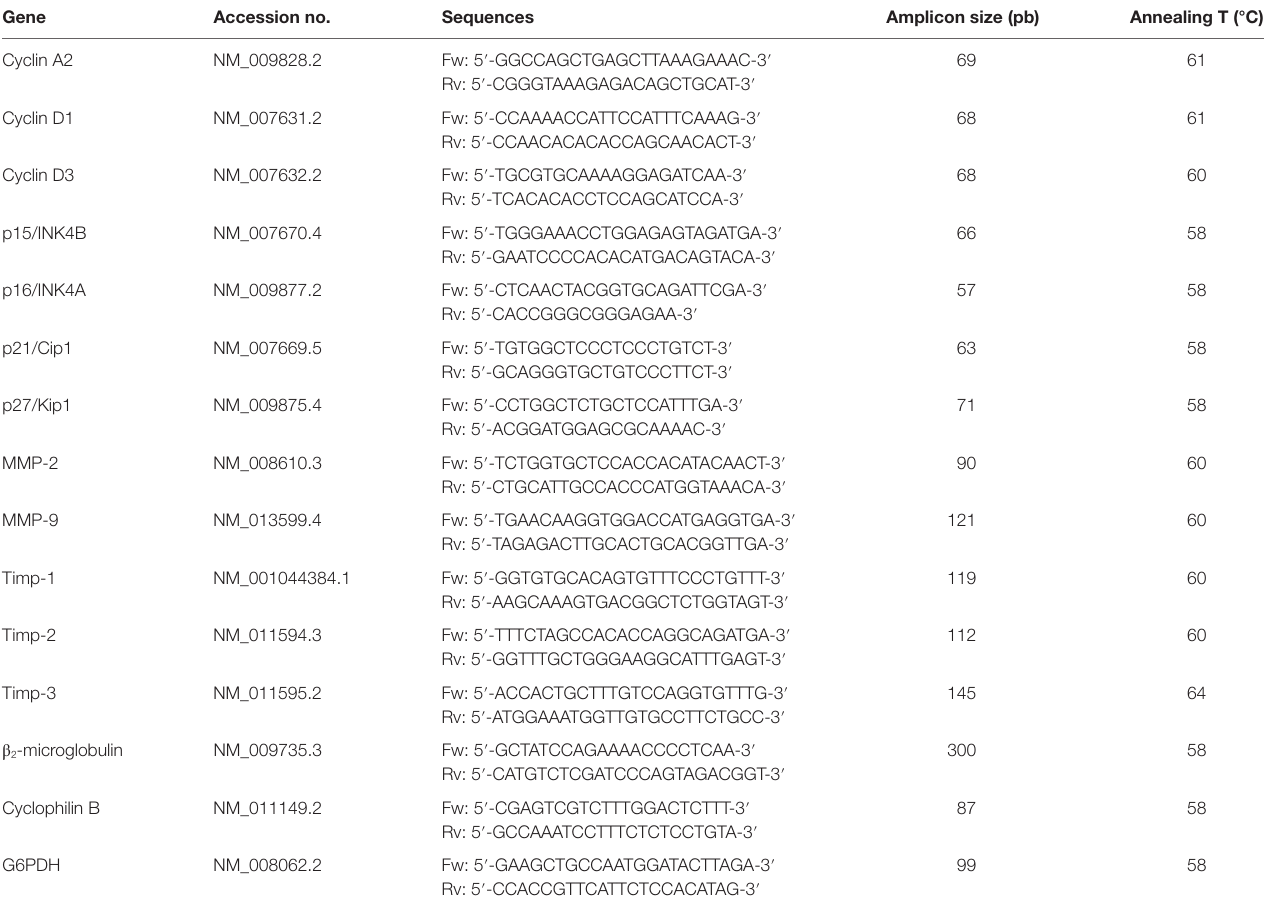
TaBle 1 | Primers sequences for quantitative real-time reverse transcription polymerase chain reaction. gene accession